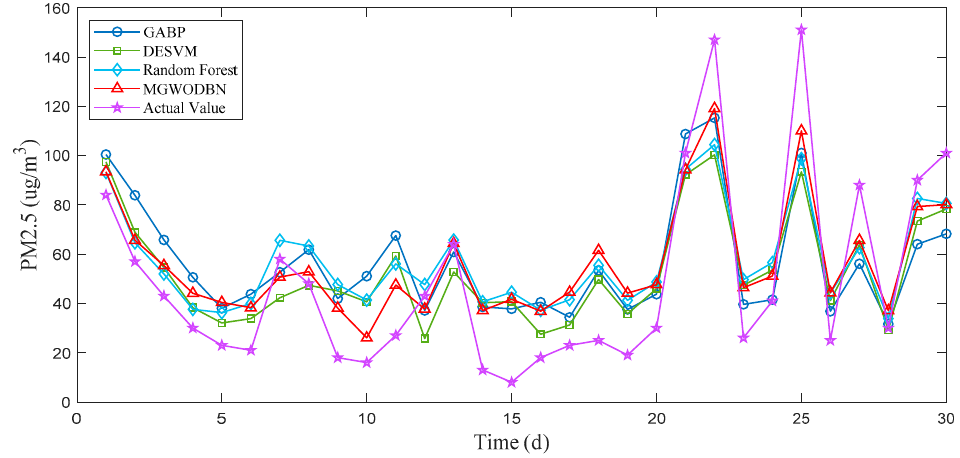
Figure 7. Prediction curves of PM2.5 concentration using different models. Table 3. Prediction errors of PM2.5 concentration using di ff erent